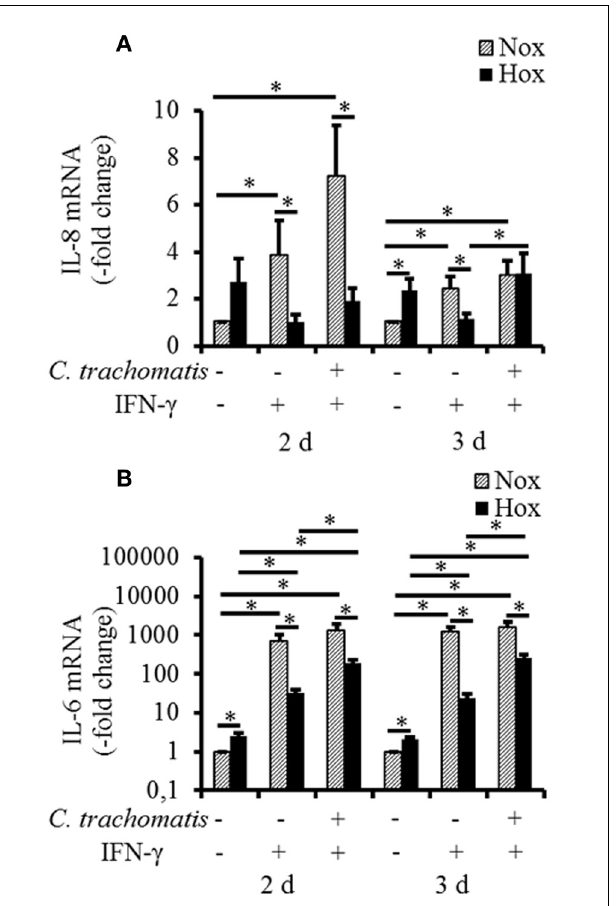
FIGURE 4 | mRNA expression of IL-6 and IL-8 in IFN- γ treated C. trachomatis infected cells under normoxic and hypoxic conditions. Quantitative analysis of IL-8 (A) and IL-6 (B) mRNA expression in IFN- γ treated C. trachomatis infected cells after 2 and 3 d cultivation under normoxic (Nox) and hypoxic (Hox) conditions ( n = 7, mean ± s.e.m., ∗ p ≤ 0 . 05).